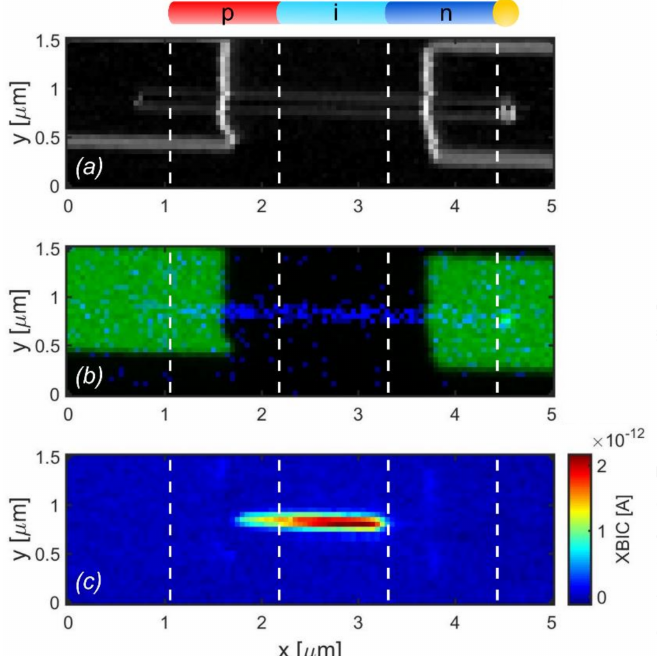
Figure 4. Multimodal imaging of a nanowire device. ( a ) Differential phase contrast (DPC) image of STXM showing the edges of the nanowire and metal contacts. ( b ) Material composition of the nanowire device, where the blue area and the green area are from XRF emission of In and Au atoms, respectively. ( c ) Color map of the XBIC signal from the nanowire device. The step length of this scan is 50 nm in both x- and y-direction with an acquisition time of 0.1 s and a latency time of 0.01 s for this fly-scan measurement. Dashed lines in these figures indicate the nominal position of each segment with the length of 1.1 µ m using the Au particle observed in ( a ) and ( b ) as a reference position. Due to variations in the nanowire growth process, the actual length of this nanowire was slightly longer than the nominal